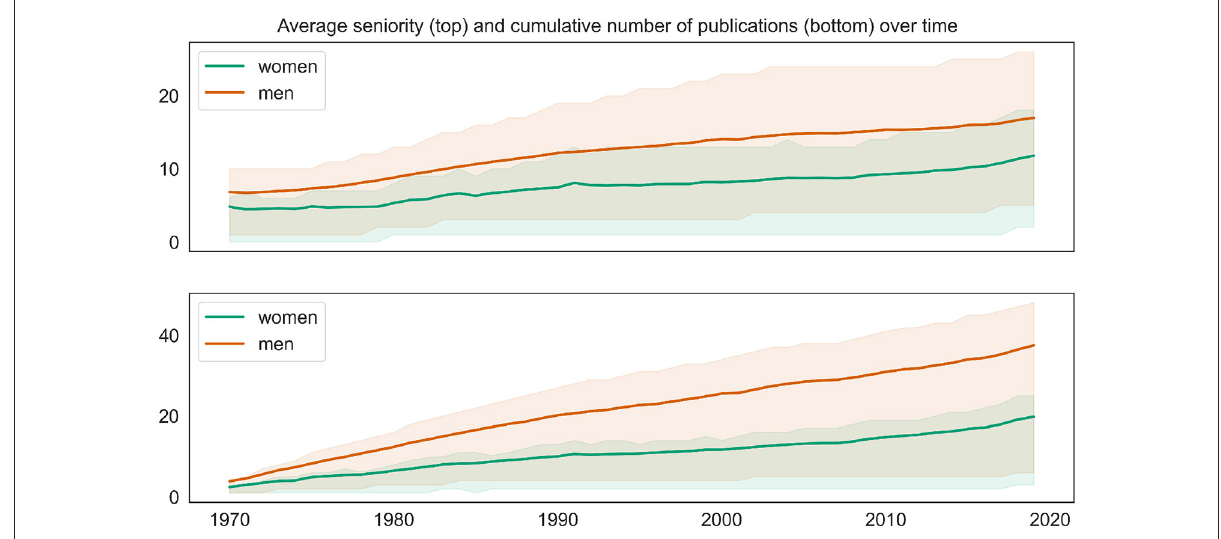
FIGURE6 Schematic illustration of the two approaches “male baseline” and “gender swapping” used to isolate and quantify the effect of gender.